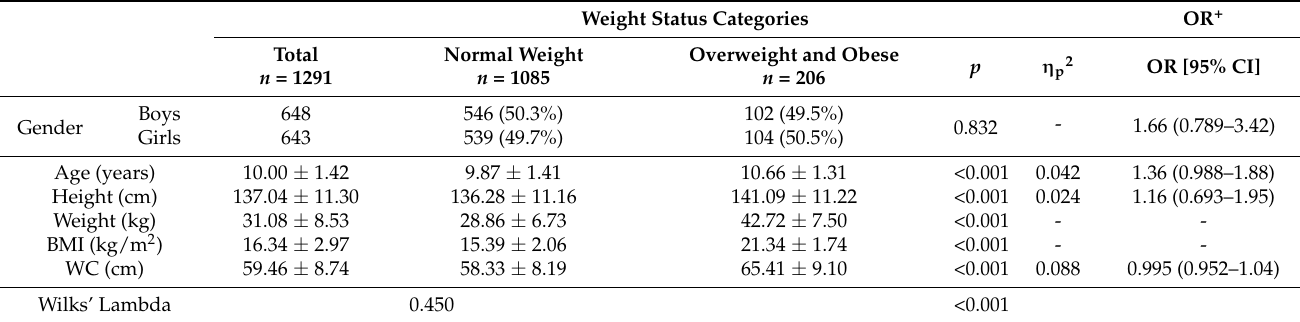
Table 6. The statistical association between weight status and anthropometric